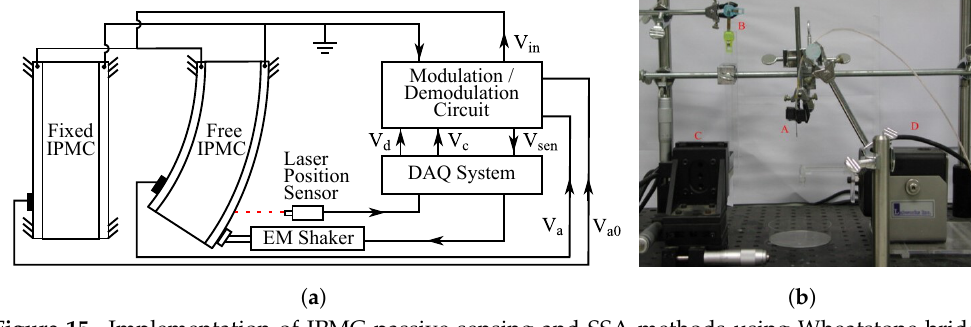
Figure 15. Implementation of IPMC passive sensing and SSA methods using Wheatstone bridge configuration by Fang et al. [11]. ( a ) Schematic view. ( b ) Experimental set-up, with ’A’ deformed IPMC, ’B’ undeformed IPMC, ’C’ laser sensor, and ’D’ shaker [11]. Reprinted from [11], Copyright (2010), with permission from